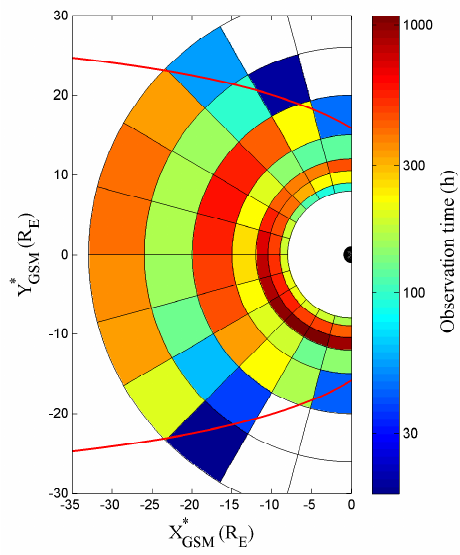
Figure 1. The distribution of total observation time of THEMIS A, B, and C in the GSM ∗ X - Y plane between 2008 and 2015. The red line is the average magnetopause, calculated by the model of Shue et al. (1998) where dynamic pressure is represented by ( D p ) = 1.66nPa and B z = 0.16nT. The blank bins indicate regions where the residence time of THEMIS is less than